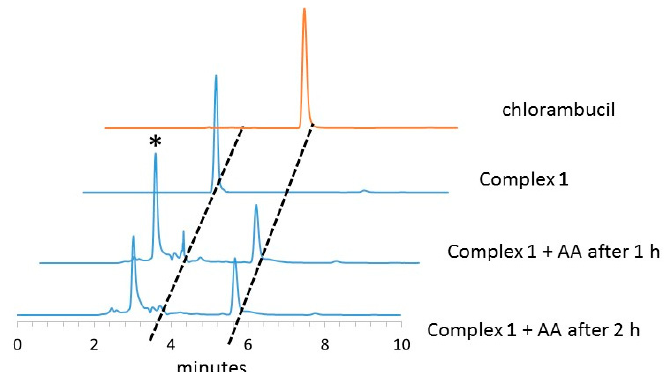
Figure 2. HPLC chromatograms of the reduction of complex 1 by ascorbic acid (AA). (* is AA) (See Materials and Methods for details).